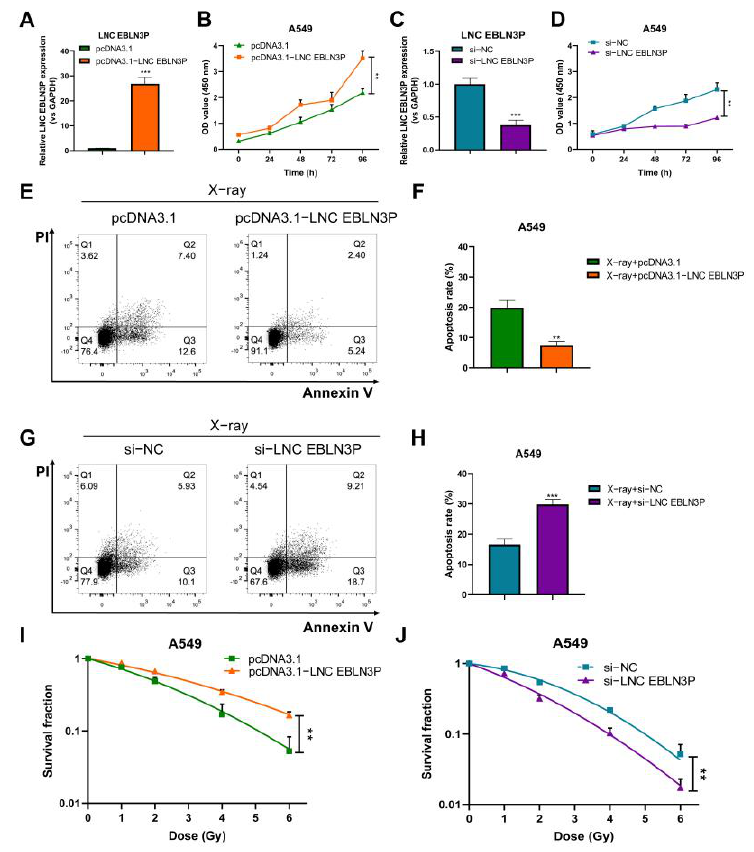
Figure 3. Downregulation of LNC EBLN3P inhibits cell proliferation and colony formation and enhances cell apoptosis. ( A – D ) The overexpression of LNC EBLN3P increases the proliferation of A549 cells, whereas its knockdown decreases the viability of cells. ( E – J ) The overexpression of LNC EBLN3P decreases both the apoptotic rate and radiosensitivity of cells, whereas its knockdown increases the apoptotic rate and radiosensitivity. Data shown in A − J represent the mean ± SD ( n = 3). ** p < 0.01, *** p <